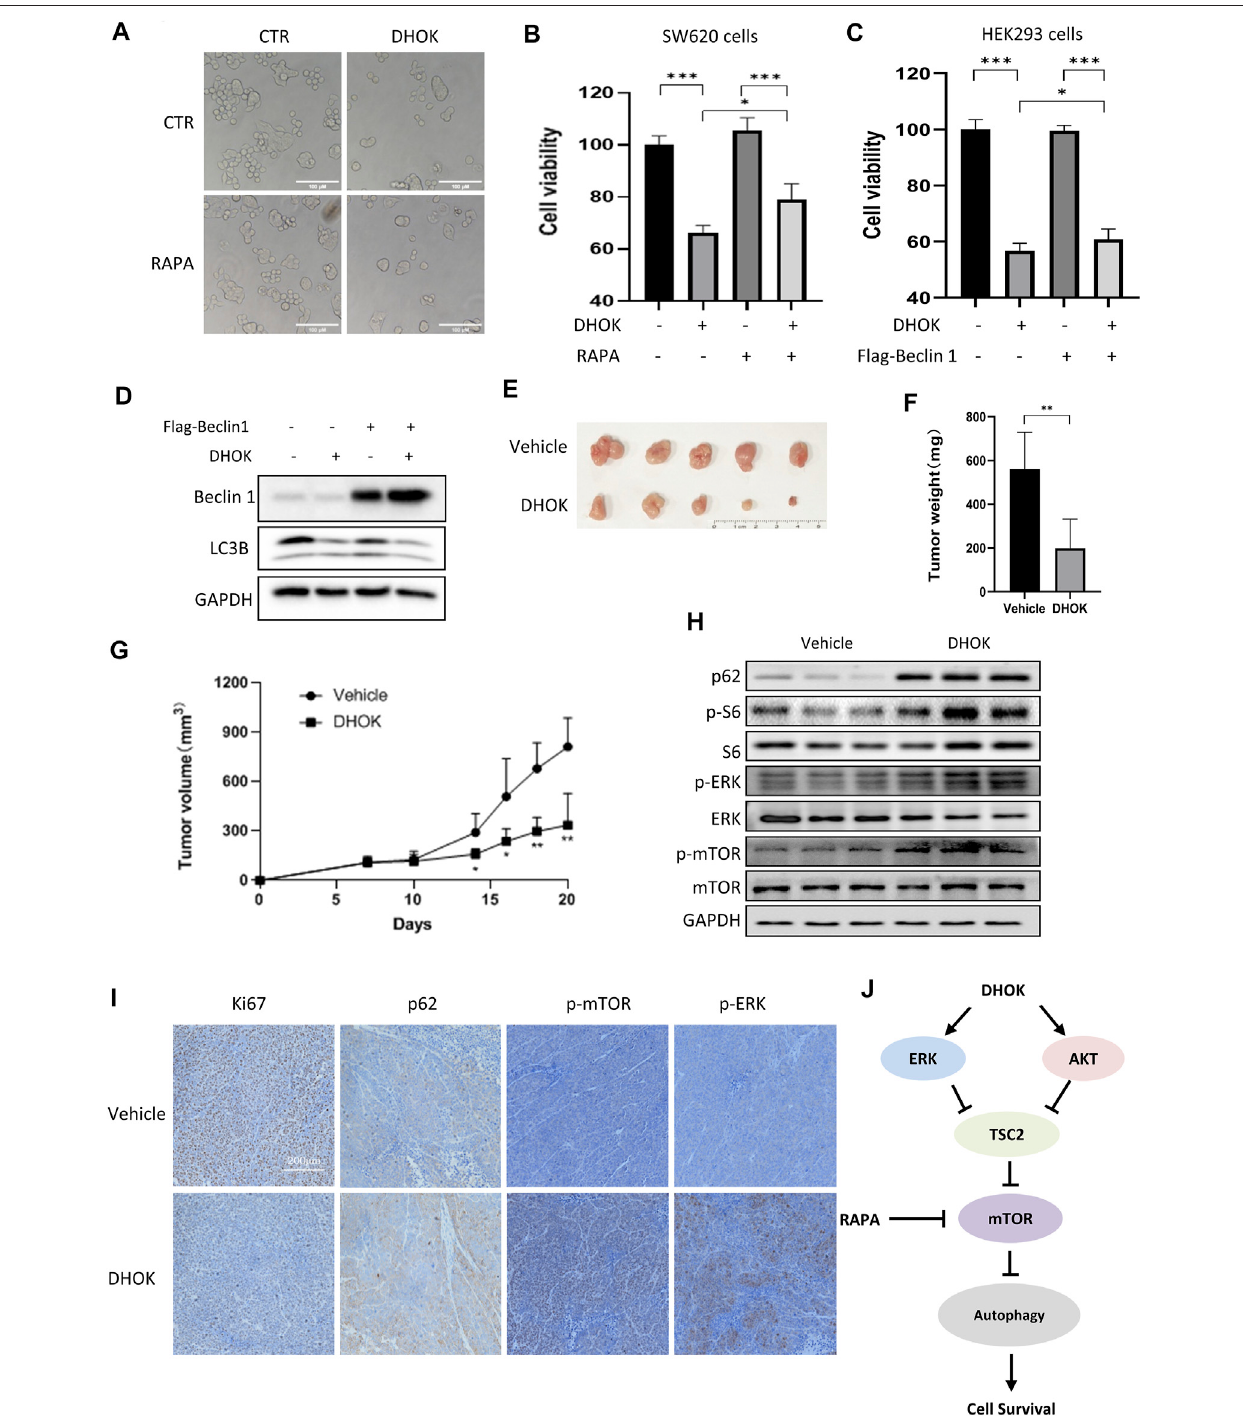
FIGURE 5 | DHOK suppresses human CRC cell growth and tumorigenesis through autophagy inhibition. (A) Cell morphology of SW620 cells under DHOK treatment (12.5 μ M, 24 h) in the presence or absence of rapamycin (100 nM). Scale bar 100 μ m. (B) as in (A) , cell viability of SW620 cells under DHOK and rapamycin treatment. * p < 0.05 *** p < 0.001 (C) HEK293 cells were fi rst transfected with Flag-Beclin 1 and then treated with DHOK (12.5 μ M, 24 h). Cell viability was measured usingMTTassay*** p < 0.001 (D) asin (C) ,cellswerecollectedandlysedforwesternblottinganalysisofBeclin1andLC3. (E,F) Xenografttumorswereestablished by subcutaneously injecting SW620 cells and treated with or without DHOK (40 mg/kg). After 20 days inoculation, all mice were sacri fi ced and tumor mass was removed,photographed andweighed.** p < 0.01 (G) Xenografttumorvolumesweremeasuredandtumor growthcurveswereplotted.* p < 0.05** p < 0.01 (H) Western blotting analysis of p62, phosphorylated S6, ERK, and mTOR protein levels in xenograft tumor tissues from the Vehicle and DHOK treatment groups. GAPDH was used as loading control. (I) Xenograft tumor tissues were collected and prepared for immunohistochemistry analysis of Ki67, p62, phosphorylated ERK and mTOR levels (scale bar: 200 µm). (J) Schematic diagram of the anti-cancer mechanism of DHOK.